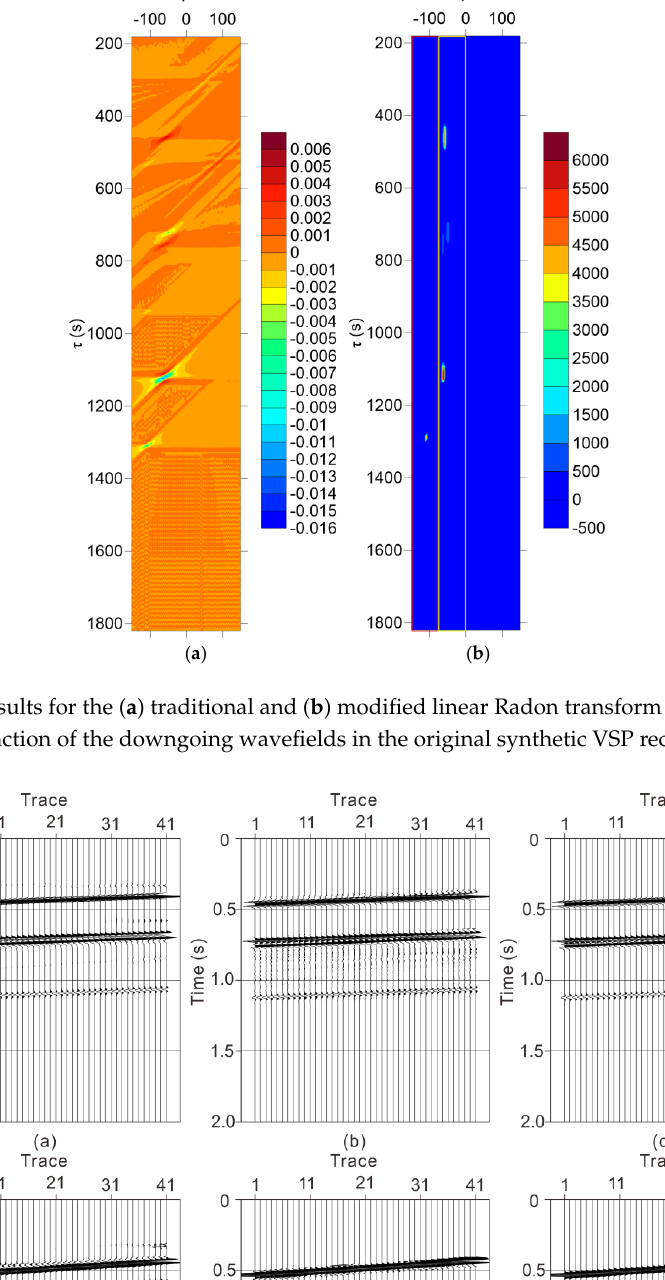
Figure 9. Results for the upgoing wavefield and theoretical wavefield. ( a ) Upgoing P-wave obtained by our method; ( b ) Upgoing P-wave obtained by the high-resolution Radon transform; ( c ) Theoretical upgoing P-wave; ( d ) Upgoing S-wave obtained by our method; ( e ) Upgoing S-wave obtained by the high-resolution Radon transform; ( f ) Theoretical upgoing S-wave.